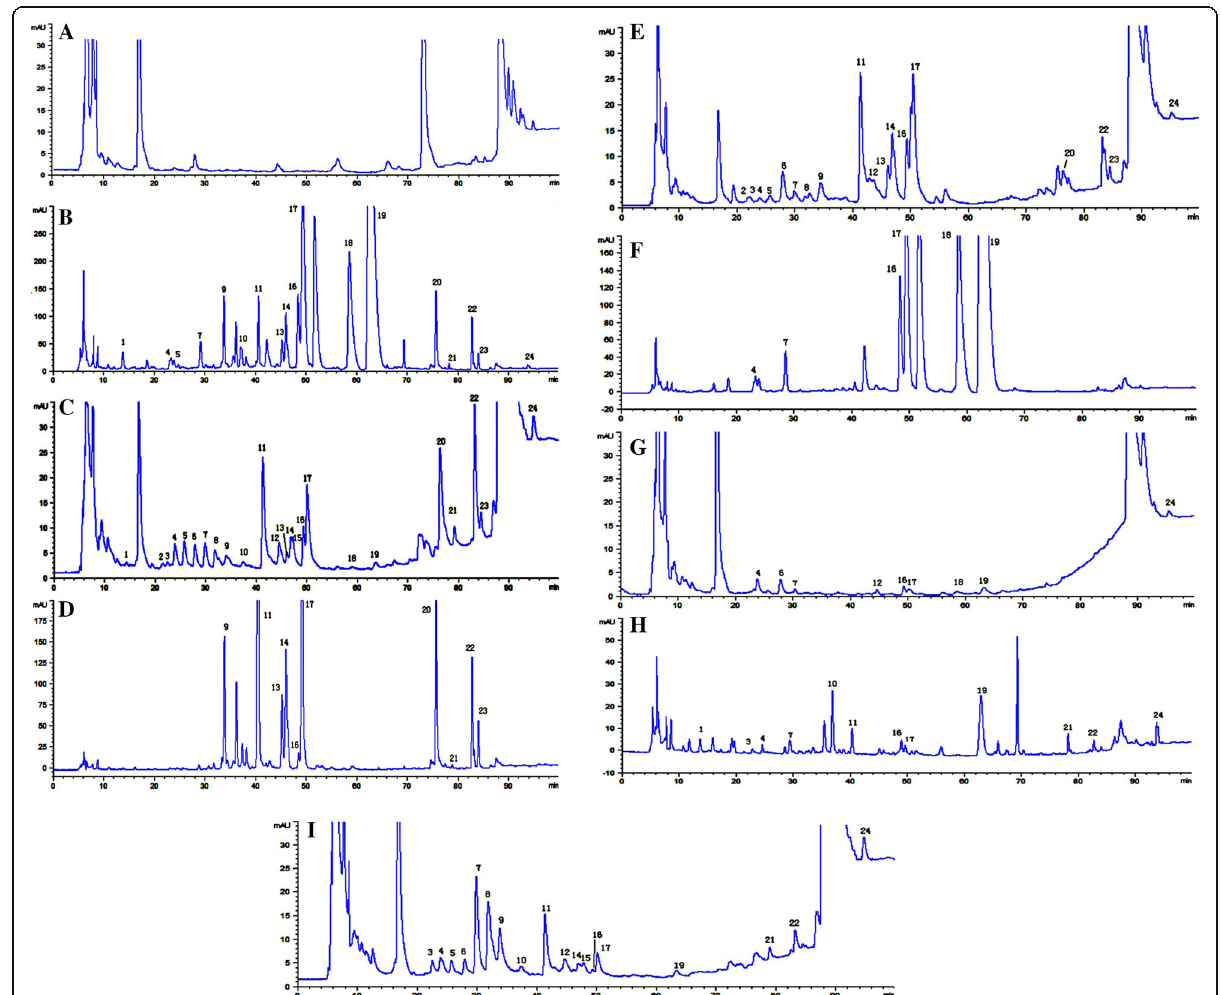
Fig. 2 The HPLC of drug containing serum after administration of the extracts of Erhuang decoction, single Scutellaria, Coptis, or licorice. a Blank serum. b Erhuang decoction extract. c Serum-containing Erhuang decoction extract. d Scutellaria baicalensis extract. e Serum-containing Scutellaria baicalensis extract. f Coptis chinensis extract. g Serum-containing Coptis chinensis extract. h licorice extract. i Serum-containing licorice